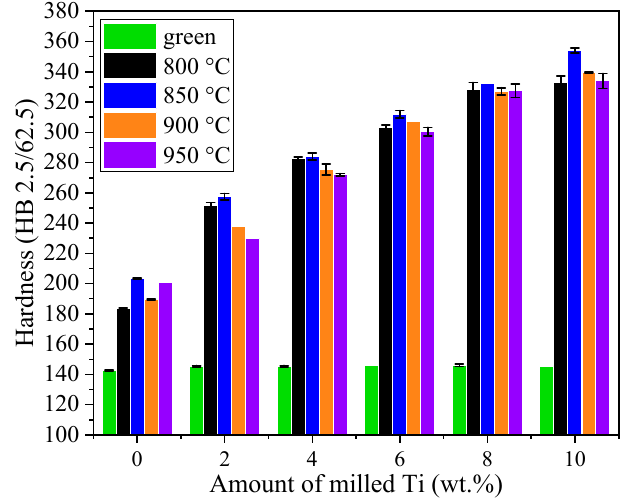
Figure 6. Hardness of the samples with di ff erent amounts of milled Ti.